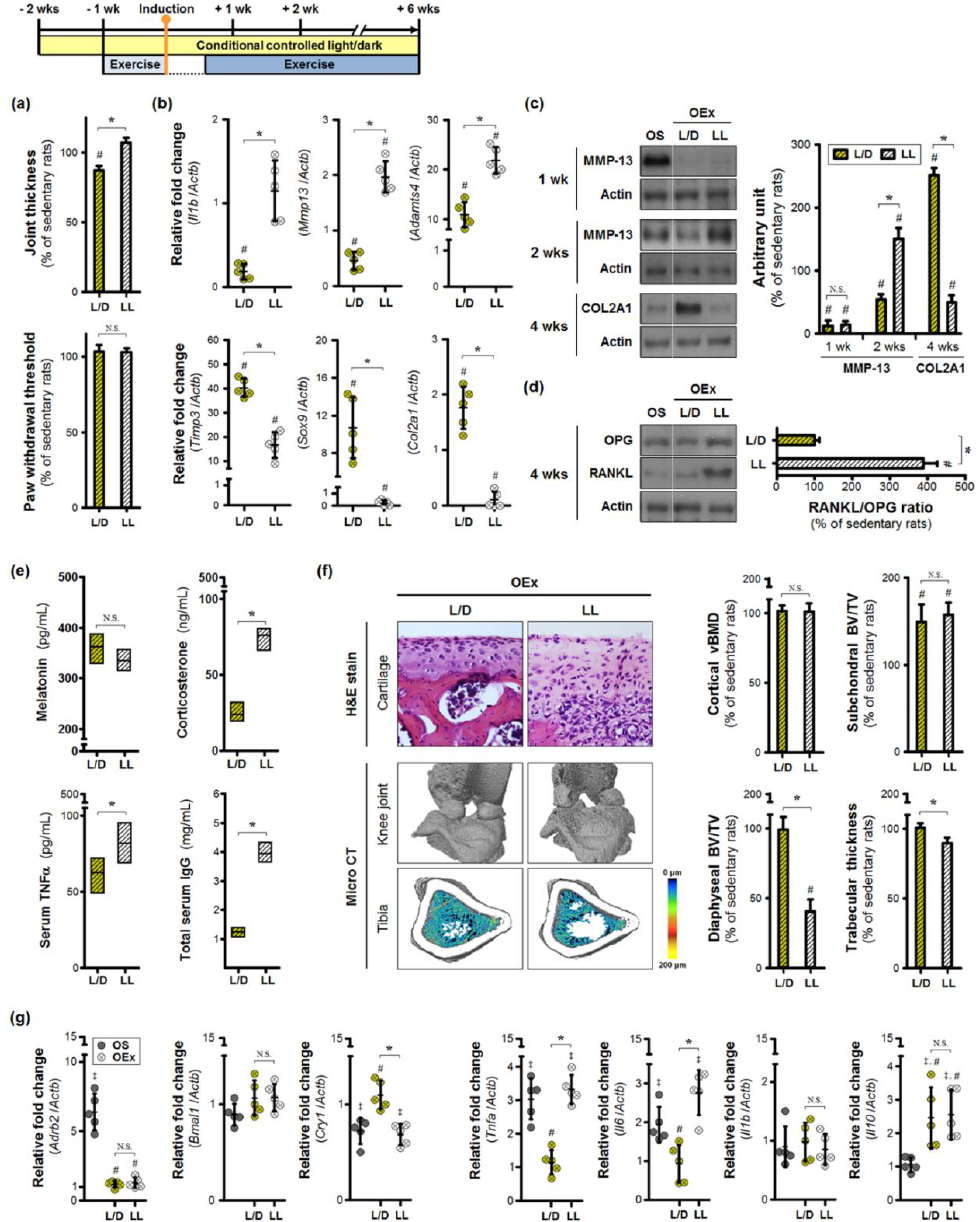
Figure 3. Moderate-intensity exercise training under continuous lighting environment amplifies catabolic signals during the progression of osteoarthritis. Di ff erent light / dark cycles were applied to osteoarthritic rats for 6 weeks. Additional treadmill exercise under each lighting condition was performed after the recovery period, following osteoarthritis induction. ( a ) Comparison of the values of joint thickness and withdrawal threshold are shown, along with alterations in ( b ) serum hormones (melatonin, corticosterone), pro-inflammatory cytokines (TNF α ), and immunoglobulin (IgG). ( c ~ d ) Lighting conditions regulate exercise-induced changes in extracellular matrix turnover in cartilage specimens. The gene expression levels were examined relative to those seen in the sedentary group. ( e ) Synovial RANKL / OPG ratios were compared between lighting conditions. ( f ) Histological and micro-CT analyses are shown. vBMD, volumetric bone mineral density; BV / TV, bone volume fraction. Magnification × 40, scale bar = 100 µ m. * p < 0.05 L / D vs. LL; # p < 0.05 Sedentary vs. Exercise-trained; N.S. not significant. ( g ) Exercise training under abnormal light / dark cycles disrupts splenic Cry1-mediated immune regulation. The relative gene expression levels were measured by real-time qPCR and compared with the control group. * p < 0.05 L / D vs. LL; ‡ p < 0.05 Con vs. OA; # p < 0.05 Sedentary vs. Exercise-trained; N.S. not